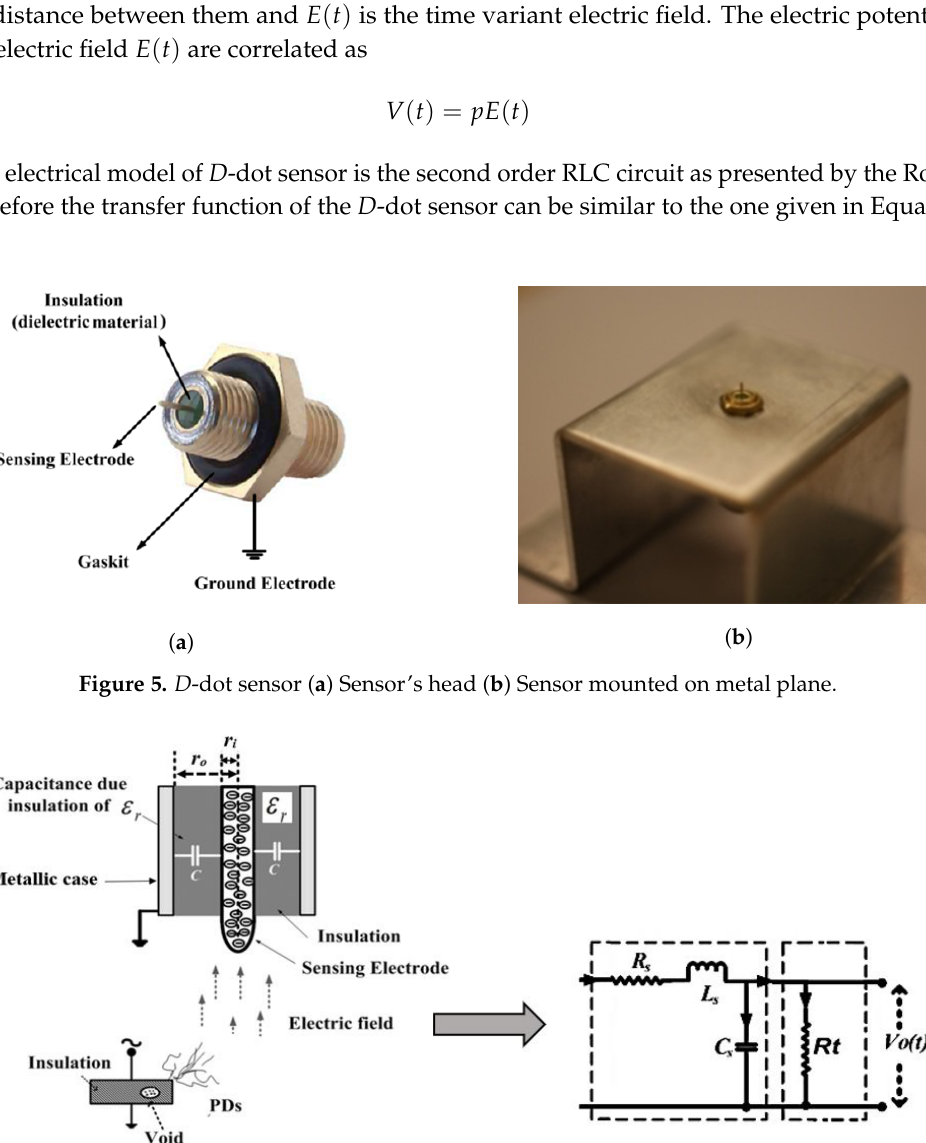
Figure 6. Electrical equivalent model of the D -dot